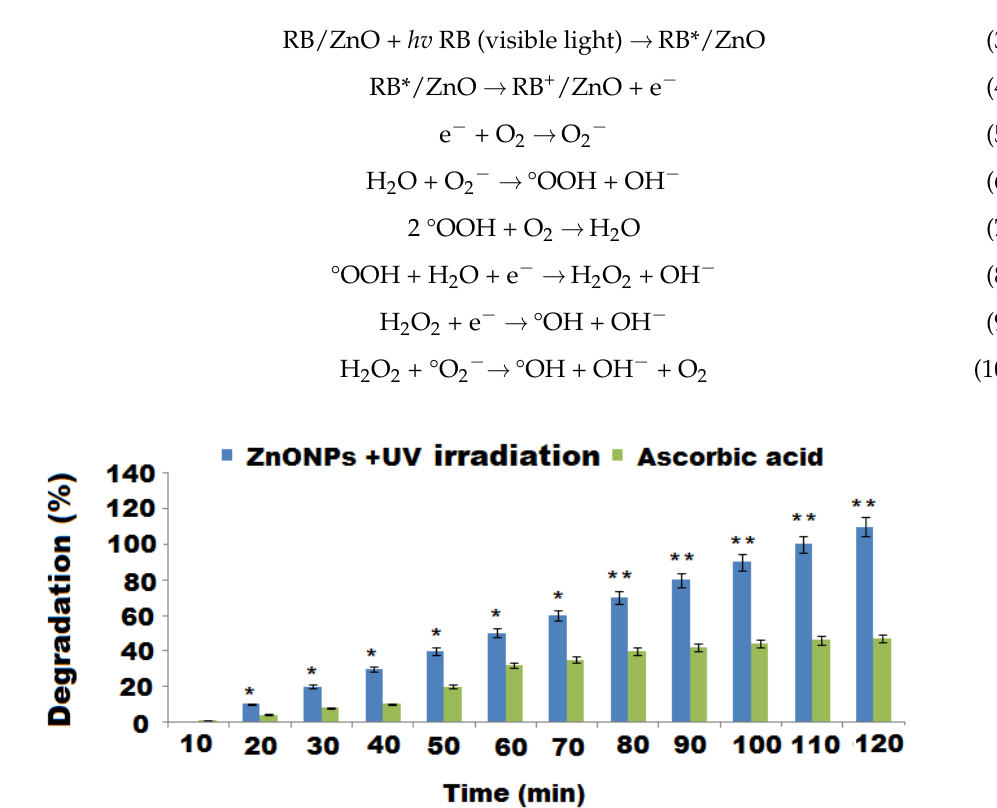
Figure 11. The photocatalytic effect of ZnONPs calculated as % of RB dye degradation in the pres- ence of UV irradiation with respect to ascorbic acid as control. * and **, p <